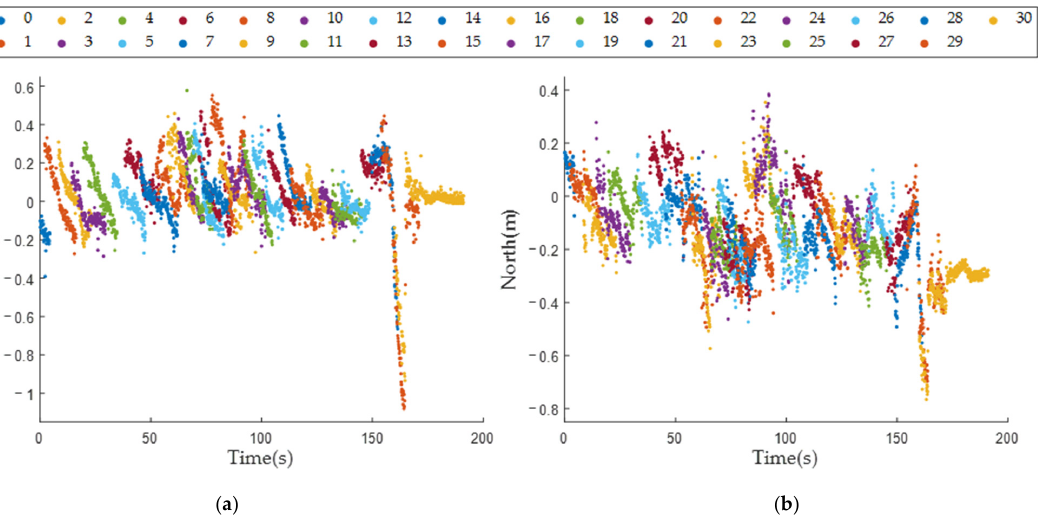
Figure 11. The position deviations of the matched targets in the east and north. ( a ) The position deviation of the matched targets in the east. ( b ) The position deviation of the matched targets in the north.